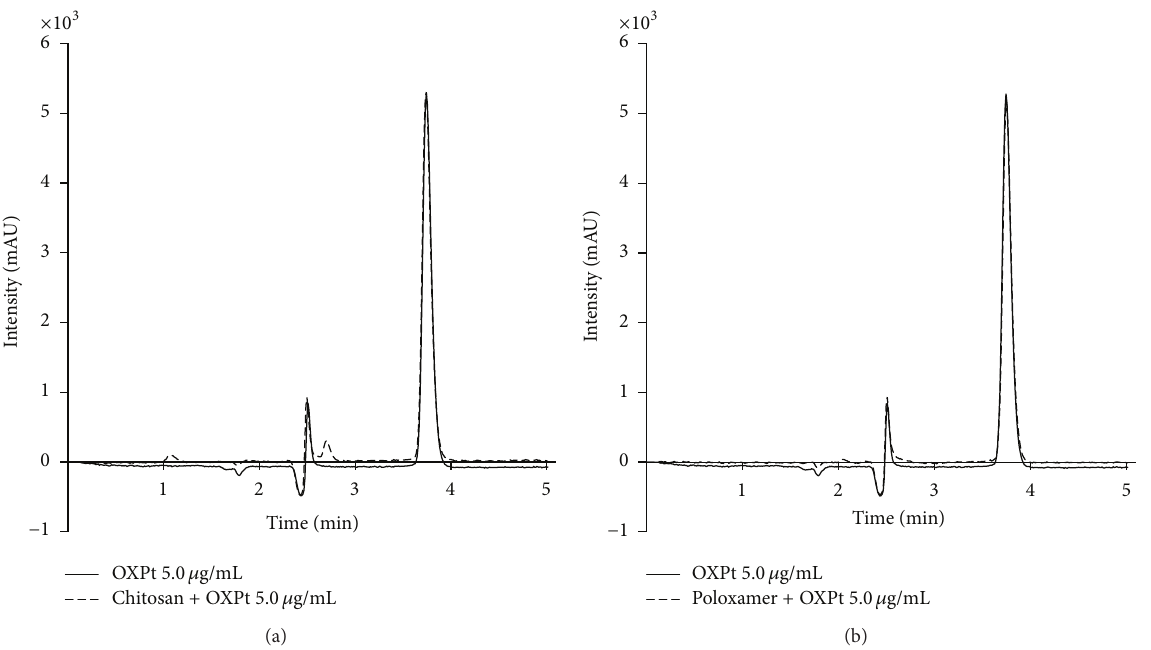
Figure 3: Overlaid HPLC chromatograms of a simple OXPt solution (5.0 𝜇 g/mL) and OXPt solutions contaminated with 5.0 𝜇 g/mL of (a) chitosan or (b) poloxamer.